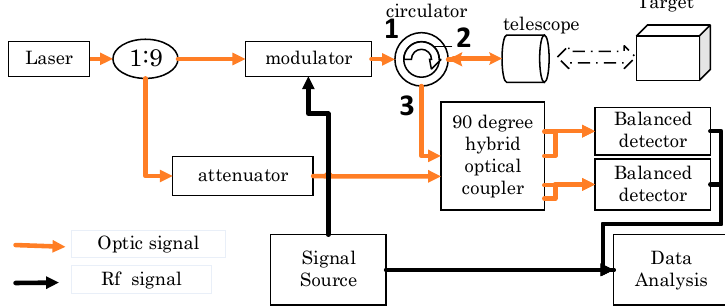
Figure 1. The block diagram of the proposed lidar system. The yellow line denotes the optical path and the black line denotes the electrical path.